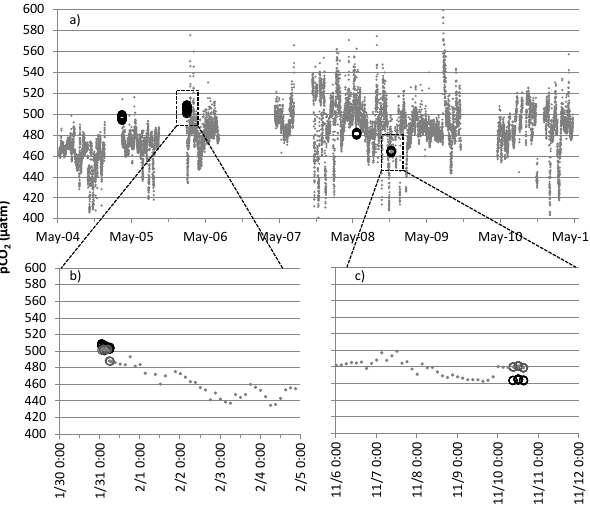
Figure 6. (a) TAO125W surface seawater MAPCO 2 observations (gray points) for the entire time series at this location with av- erage R/V Ka’imimoana underway p CO 2 data within 10km and 10min of the MAPCO 2 measurements (black open circles). Two examples of comparison data over 1-week time series are shown in panels (b) and (c) , with MAPCO 2 measurements correspond- ing to the average underway observations illustrated in gray open circles. Selection boxes in (a) are not to scale of actual axes in (b) and (c) panels. Ka’imimoana data from NOAA PMEL, http: //cdiac.ornl.gov/oceans/VOS_Program/kaimimoana.html. at ± 2 µatm on 31 January 2006 at 14:00:00, but as the